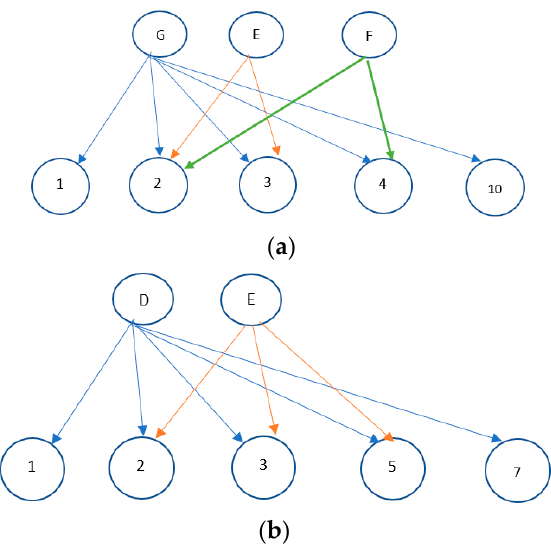
Figure 3. An Example of a CR-WMN.